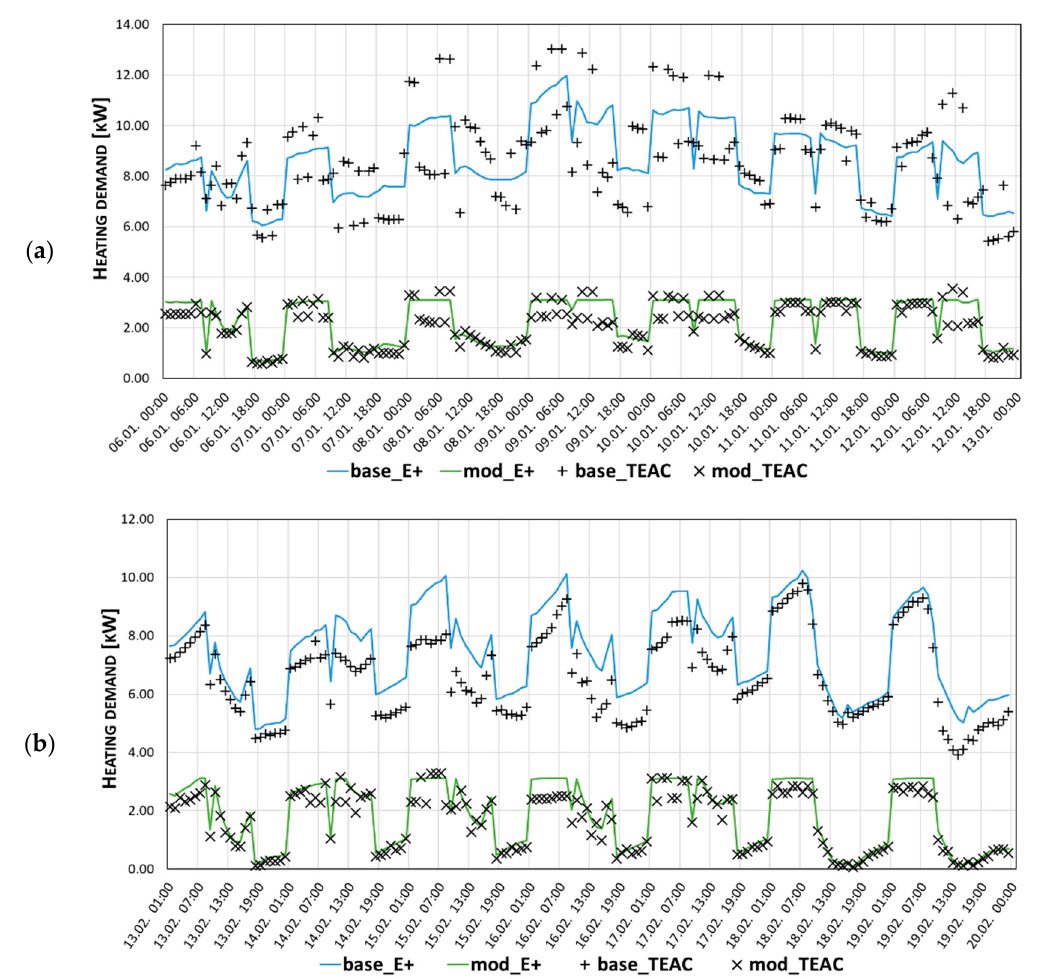
Figure 5. Comparison of heating demands obtained using the Energy Plus (solid lines) and the ANN pre-dictions (markers) for Czestochowa ( a ) and Olsztyn ( b ).